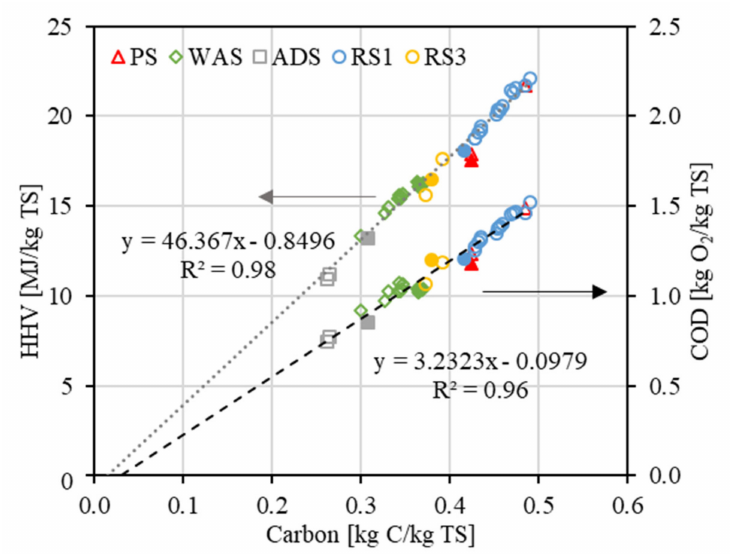
Figure 4. Relation between the HHV and the carbon content of all sewage sludges investigated (filled icons) and their hydrochars (framed icons) resulting from